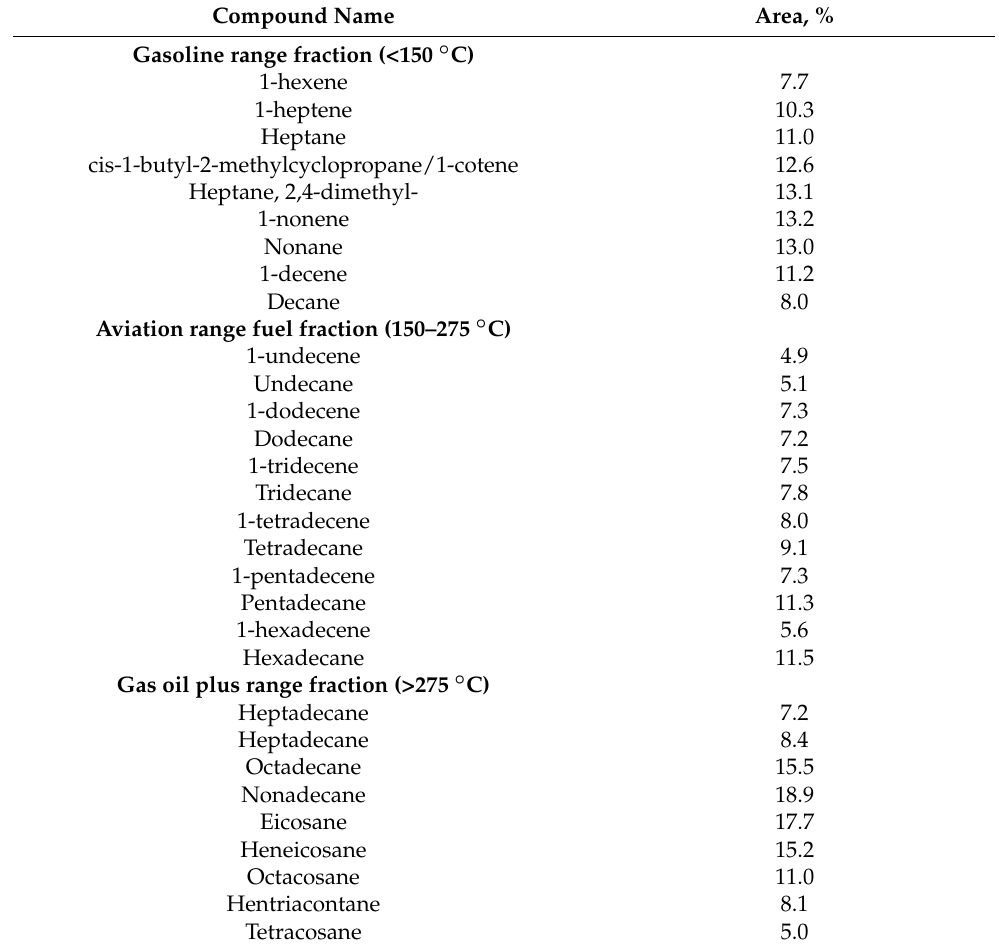
Table 9. Gas chromatographic analysis of the distillate fraction of plastic crude oil obtained after pyrolysis of landfill liner plastic waste